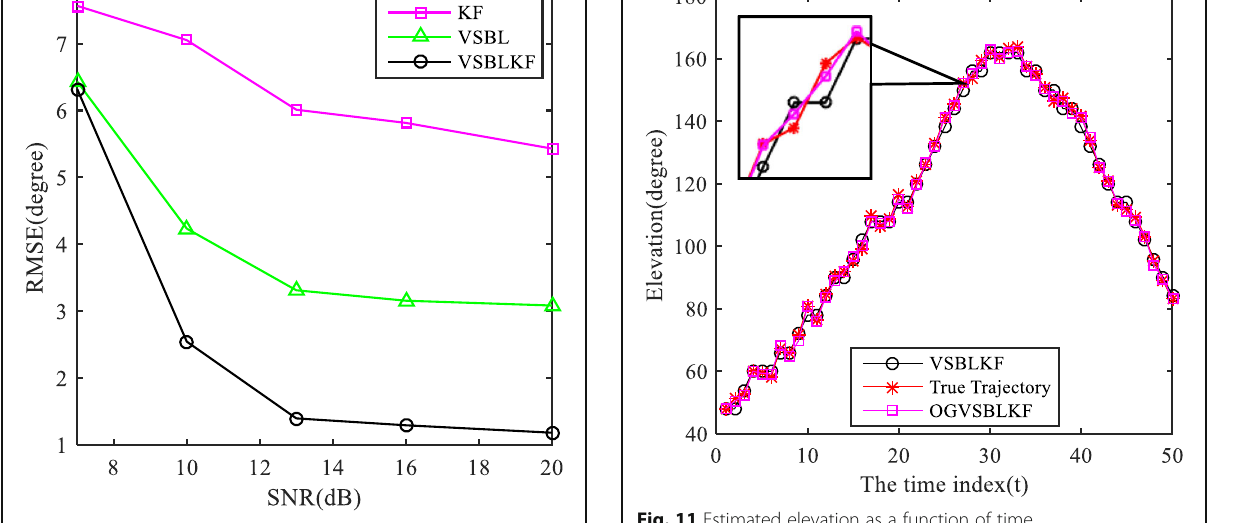
Fig. 9 RMSE as a function of SNR in the on-grid